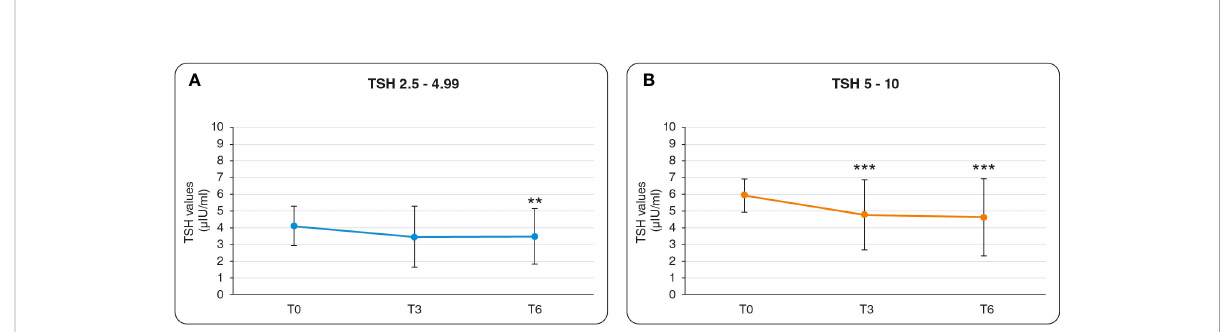
FIGURE 1 Graphics of changes in TSH values. (A) Results referred to Group 1: the variation of TSH in the range 2.5 – 4.99 ( m IU/ml). Statistical relevance is assigned to the comparison of T3 versus T0, and of T6 versus T0. (B) Results referred to Group 2: the variation of TSH in the range 5 – 10 ( m IU/ ml). Statistical relevance is assigned to the comparison of T3 versus T0, and of T6 versus T0. ** = p value < 0.01, *** = p value <0.001.